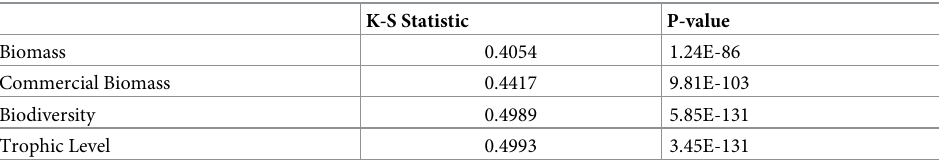
Table 3. Kolmogorov-Smirnov test results for nonlinearity of the differences between the additive effects of pro- duction, other mortality, and vulnerability forcing against the combined